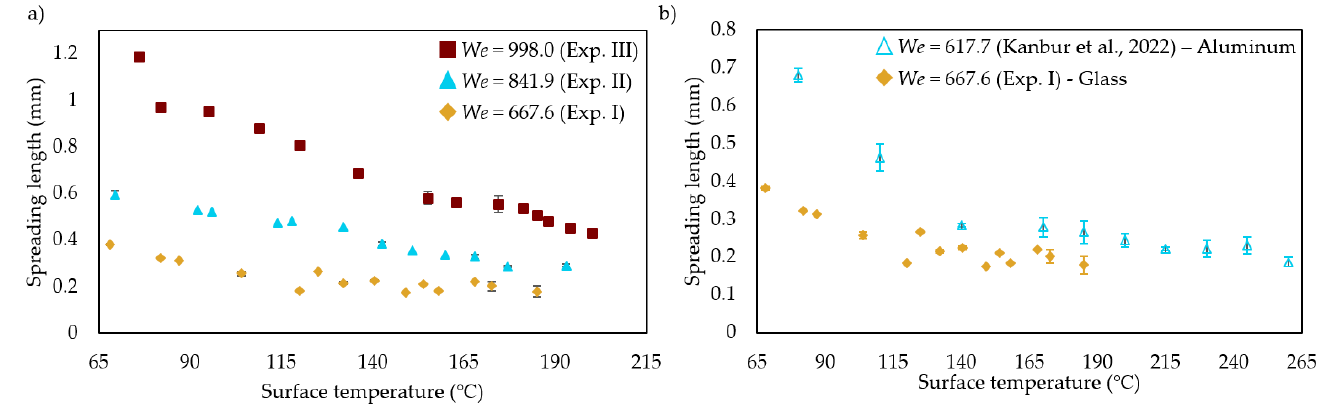
Figure 7. Spreading length measurements of ( a ) Experiments I–III and ( b ) comparative cases of Experiment I of this study and another study from Ref. [31].